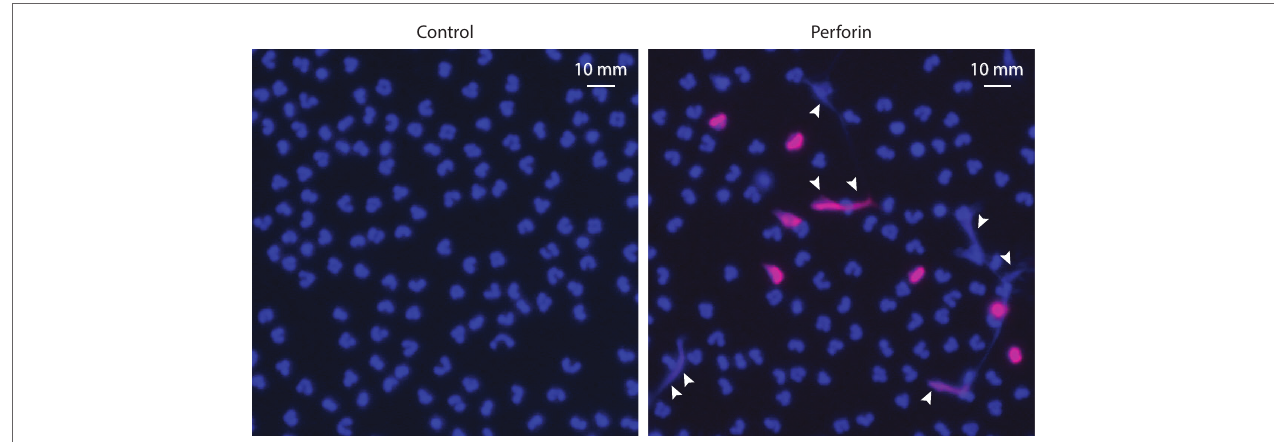
FigUre 3 | purified perforin induces pad activation and the release of extracellular dna in neutrophils . Human neutrophils (5 × 10 5 cells/50 μ L) in HBSS/10 mM Hepes/1.5 mM CaCl 2 were plated onto standard microscope slides coated with poly- d -lysine (Sigma) and incubated for 30 min at 37°C to allow for cell attachment. Neutrophils were then incubated in the absence or presence of sublytic amounts (500 ng/mL) of purified perforin (Enzo Life Science) for 1 h at 37°C, as previously described (58). Then, the cells were fixed, permeabilized, and stained with anti-histone H3 (citrulline 2 + 8 + 17) antibodies (H3cit) and Alexa Fluor 594 goat anti-rabbit F(ab ′ ) 2 fragment (Invitrogen, Cat# A-11072). Cells were mounted with ProLong Gold (Molecular Probes) plus DAPI. Samples were analyzed using a Zeiss axioscope microscope. Excitation filter: 510–560 nm for Alexa Fluor 594 and excitation filter: 300–390 nm for DAPI. Merged images of DAPI (blue) and H3cit (red) staining are shown. Perforin induces PAD activation (detected by citrullination of histone H3) and the extracellular release of neutrophil DNA (arrowheads). The experiments were performed on at least four separated occasions, with similar